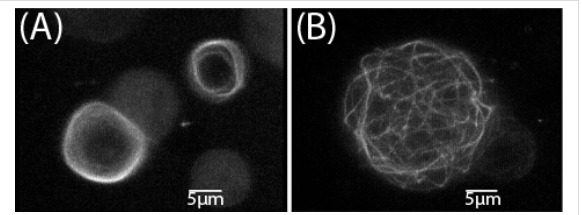
Figure 4: Dependence of actin/ α -actinin network structures on the vesicle size. The 3D reconstructions of networks by confocal fluores- cence microscopy (at a temperature of 4 °C). (A) Examples of rings obtained in vesicles of diameter d < 12 μ m. (B) Spiderweblike networks formed in vesicles with diameter d > 12 μ m (Reprinted with permission from [60]. Copyright (2002) American Physical